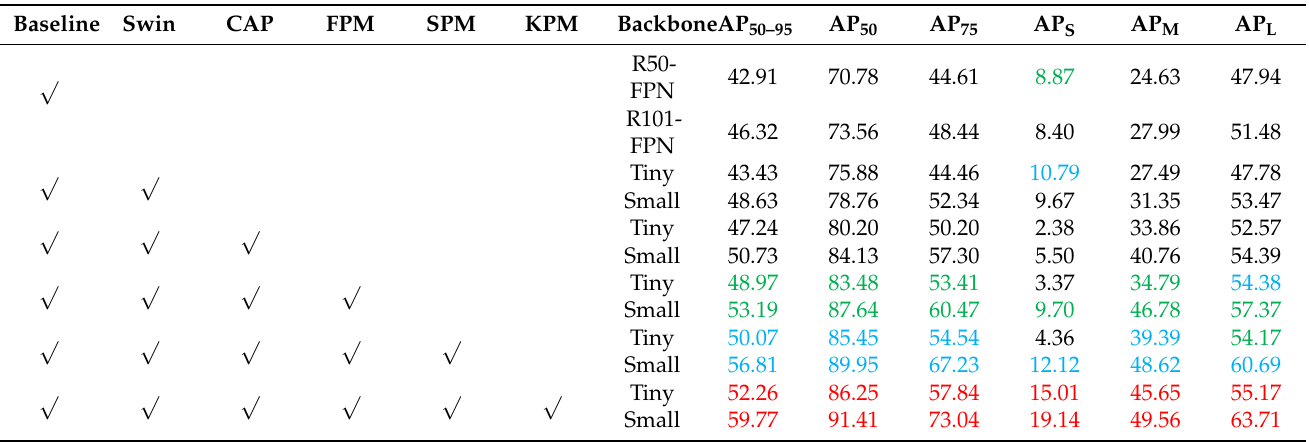
Table 5. Longitudinal comparison results obtained in ablation experiments conducted on the COD10K dataset (the top three performances are highlighted in red, blue, and